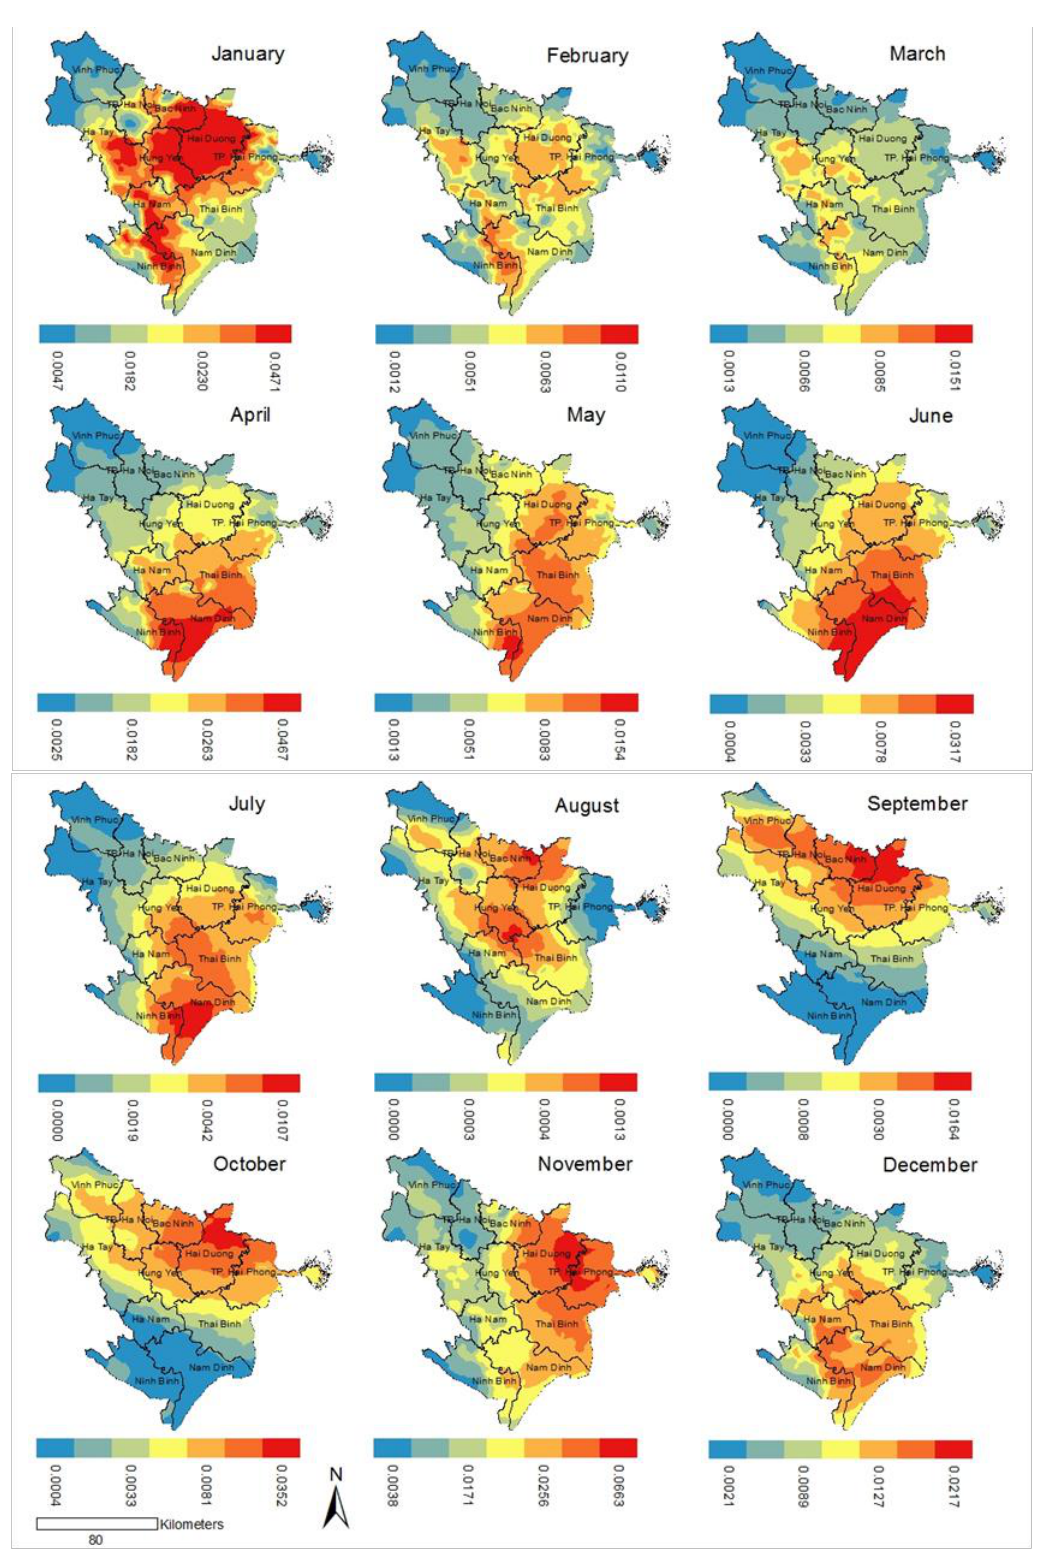
Figure 6. Monthly probability prediction of HPAI H5N1 occurrence in the Red River